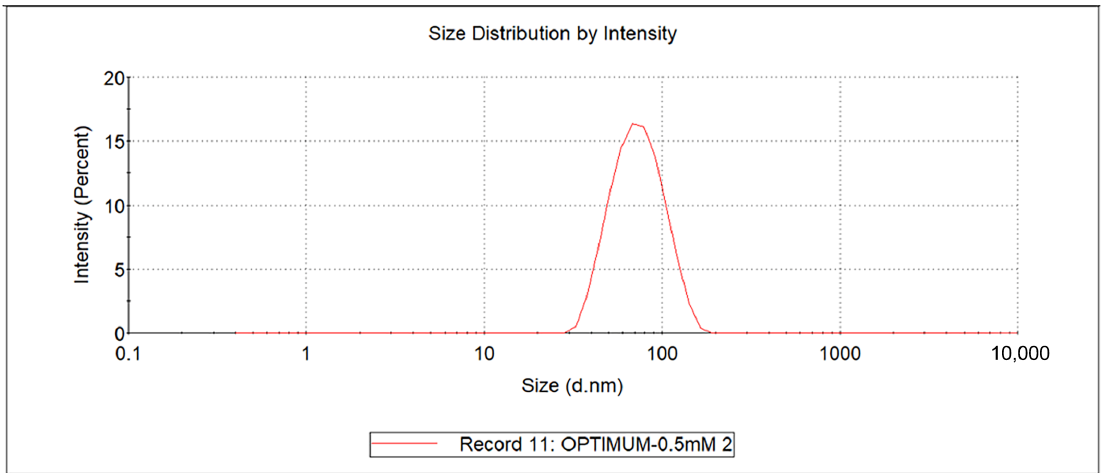
Figure 1. Se-MOP size distribution by intensity. The horizontal coordinate represents the particle size (nm), and the vertical coordinate represents the intensity (%). All particle sizes are concentrated in the range of one peak.